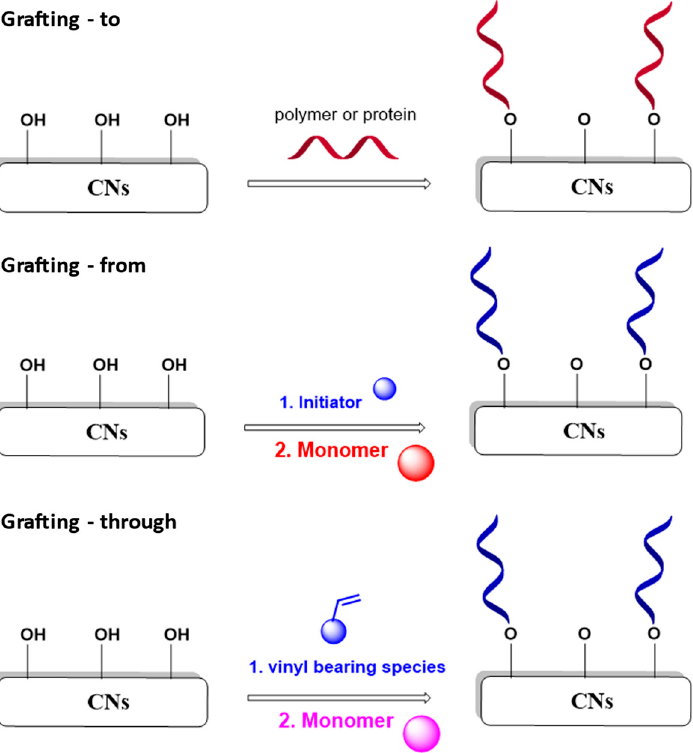
Figure 4. Scheme showing grafting-from, grafting-to and grafting—Through of polymers onto CNs.